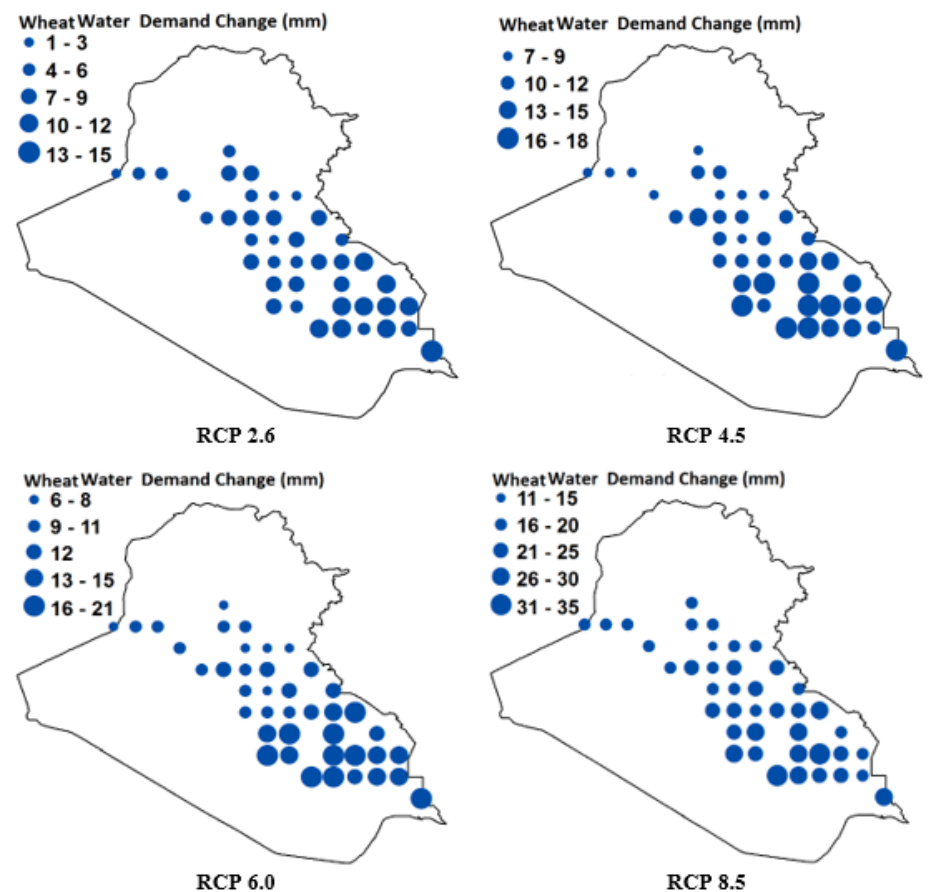
Figure 8. The geographical variations of the changes of water needs for wheat between 2070 and 2099 and 1971 and 2000 for four RCPs.